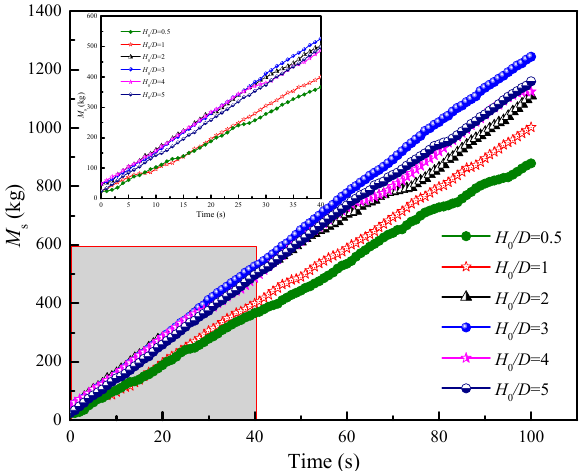
Figure 8. The cumulative mass with the measuring time for different aspect ratios.